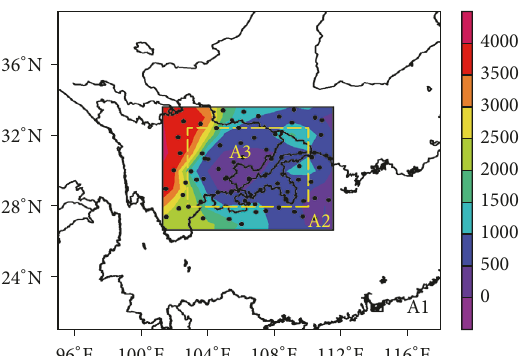
Figure 1: Model domains (i.e., A1, A2, and A3), topography, and the distribution of observation stations (black